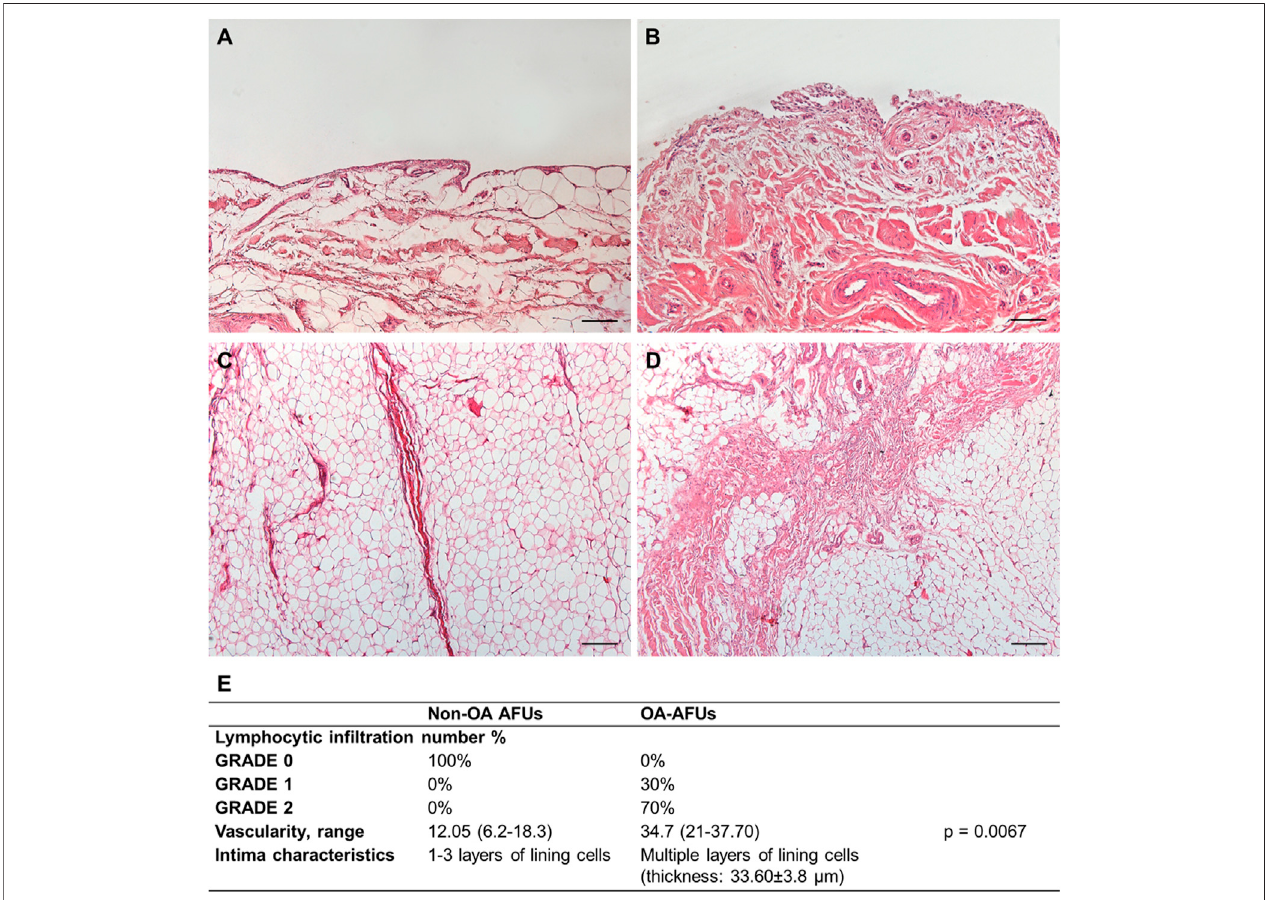
FIGURE 2 | (A , B) Histological features of the IFP compartments in the non-OA (A , C) and OA-IFP-SM AFUs (B , D) ; in presence of OA, typical thick septa are identi fi ablewithintheadipocytes. (E) Tableshowingthecombined IFP-SMAFUhistopathologicalgradingresults; speci fi cally,lymphocyticin fi ltration,median vascularity range and intimal layer thickness were considered. Scale bars: 200 µm (A , B)